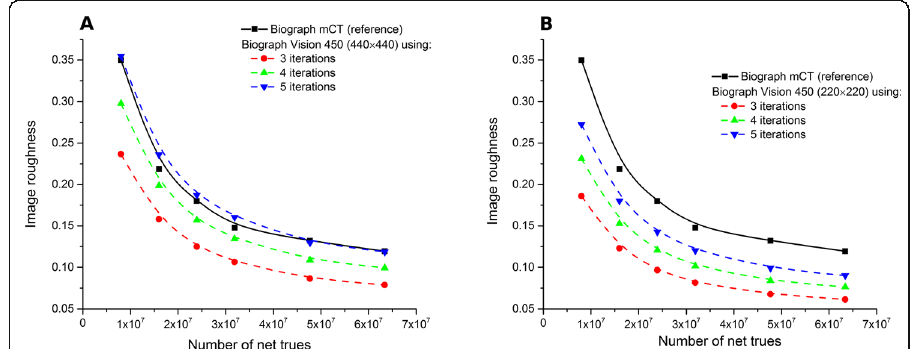
Fig. 4 Image roughness as a function of the number of net trues. Data reconstructed from the mCT (set as the reference) using 3 iterations, 21 subsets, and no post-filtering (matrix size 200 × 200). Vision data were reconstructed using 5 subsets, no post-filtering, and between 3 to 5 iterations. a 440 × 440 and b 220 ×